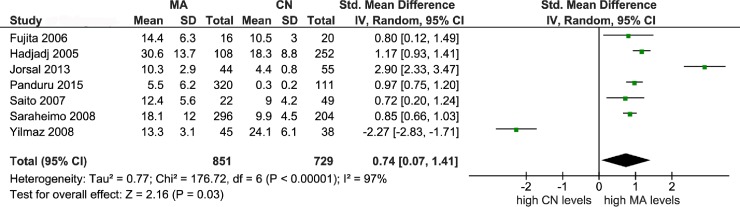
Forest plot of control versus macroalbuminuria comparison.LEGEND: MA: macroalbuminuria; CN: control; SD: standard deviation; CI: confidence interval; df: degree of freedom.